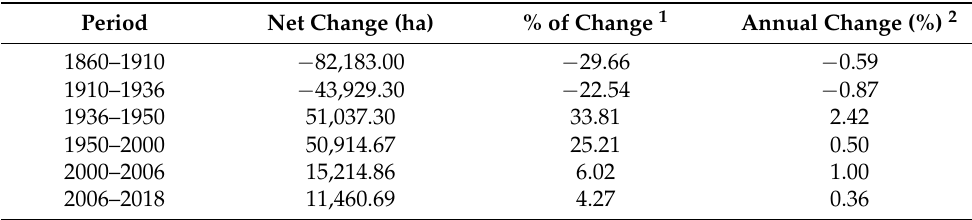
Table 4. Calculation of net change (ha), net percent of change and annual change for each successive pair of years.